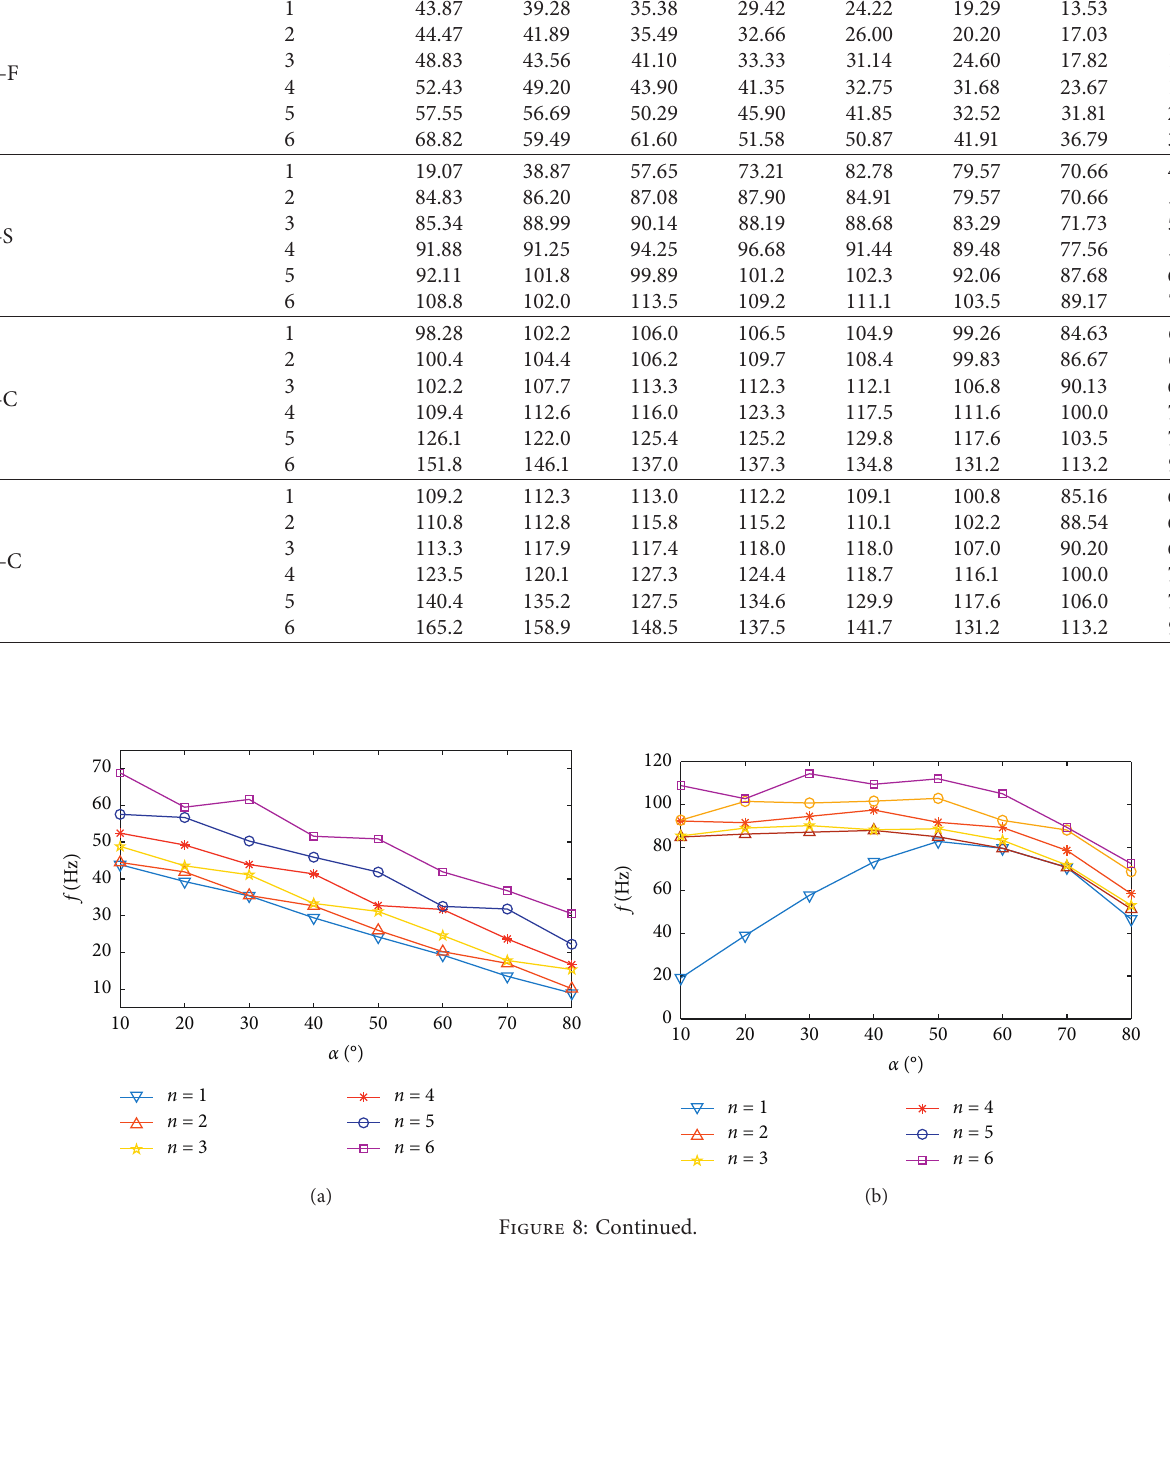
Table 4: Frequencies of conical shell with different half-cone angel α Boundary